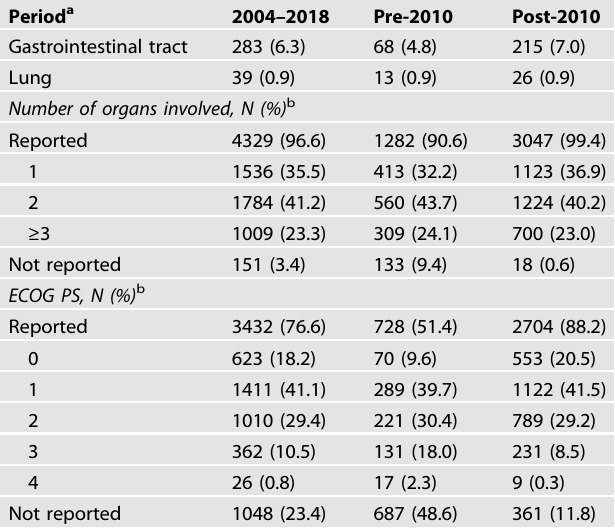
After fi rst-line therapy, 63.4% of patients with available informa- tion achieved at least hematologic PR (including CR: 23.2% and VGPR: 21.2%, Table S7). The hematologic response rate was 68.4% with bortezomib-based regimens (CR: 26.1%, VGPR: 25.7%); 49.0% (CR: 14.3%, VGPR: 13.4%) with chemotherapy, and 53.7% (CR: